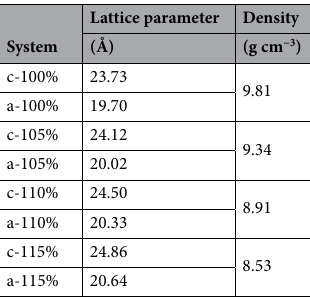
Table 1. Parameters of our crystalline (c-) and amorphous (a-) samples.